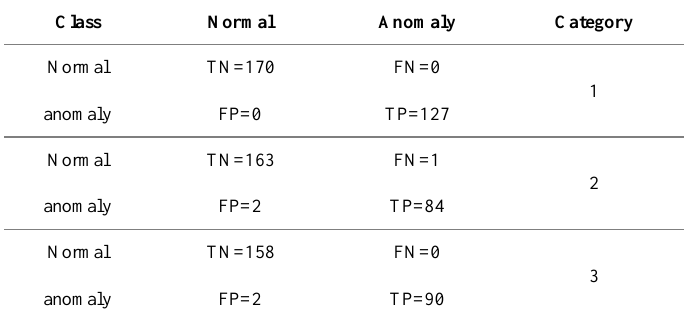
Table 2. Confusion Matrix associated with test data in proposed method on Category 1 to